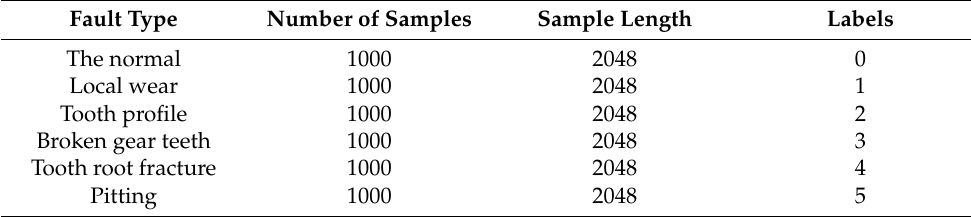
Table 3. Gearbox data set.